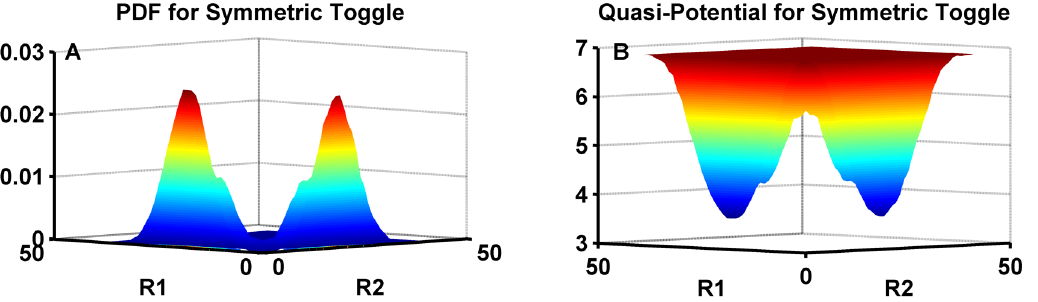
Figure 5. The probability distribution function and the quasi-potential of the genetic toggle switch without a load. (A). The probability distribution function of a toggle switch without a load. The x- and y- axes here represent the number of molecules of Repressor 1 and Repressor 2 respectively, while the z-axis is the frequency of its occurrence. Note that the distribution is symmetric as expected. (B). The quasi- potential of the symmetric toggle switch, showing the symmetric double-well potential constructed by taking the negative logarithm of the probabilities shown in (A). A small offset of 0.001 was added to the probabilities to prevent taking the logarithm of zero. This does not change the shape of the well.